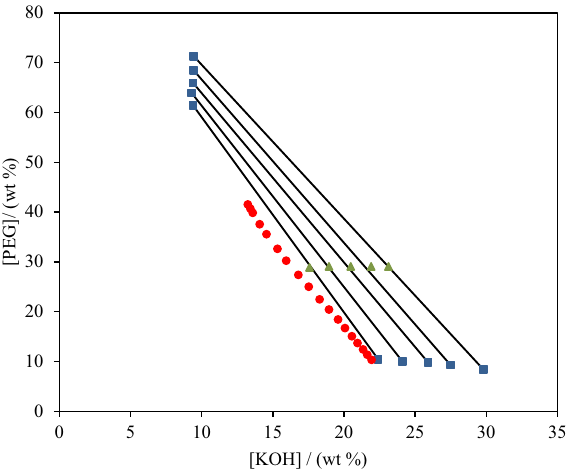
Figure 1. Phases diagram for the system {KOH + PEG 600 + H 2 O} at 298 K: binodal curve ( ● red), tie-line overall composition ( ▲ ), tie-line phase composition ( ■